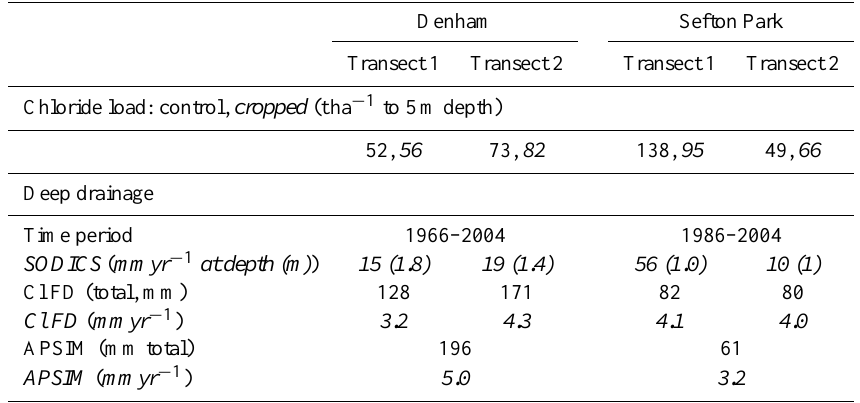
Table 2. Deep drainage estimated using chloride mass balance, chloride front displacement and APSIM simulations of paddock records using historic weather